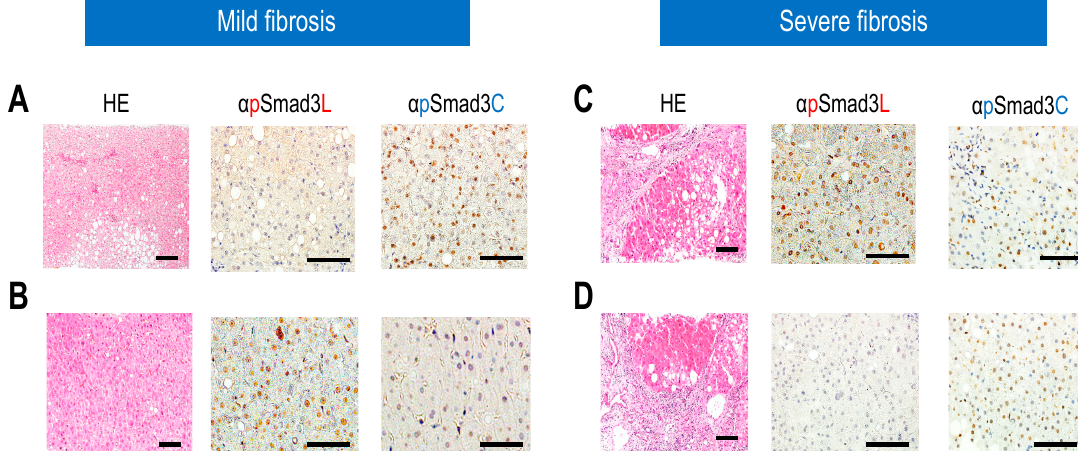
Figure 2. Two distinct hepatocytic Smad phospho ‐ isoform signaling pathways in livers with nonalcoholic steatohepatitis (NASH): pSmad3L ‐ dominant and pSmad3C ‐ dominant. ( A ) This liver specimen showing mild fibrosis (hematoxylin ‐ eosin on HE column) was obtained from patient 5 in Table 1, who had not developed hepatocellular carcinoma (HCC) for 15 years following histopathologic diagnosis of NASH. Hepatocytes retained phosphorylation at Smad3C ( α pSmad3C column) but showed little phosphorylation at Smad3L ( α pSmad3L column). ( B ) This liver specimen was obtained from patient 18 in Table 1, who developed HCC within 8 years after liver biopsy. The specimen showed degrees of fibrosis and necroinflammatory activity similar to those in ( A ). Smad3 in hepatocytic nuclei was phosphorylated sparsely in the C ‐ terminal region ( α pSmad3C column) but intensely in the linker region ( α pSmad3L column). ( C ) In the cirrhotic liver specimen obtained from patient 26 in Table 1 who was diagnosed with HCC at the time of liver biopsy, phosphorylation of Smad3L in hepatocytic nuclei was high, while C ‐ terminal phosphorylation of Smad3 was suppressed. ( D ) In another cirrhotic liver specimen, obtained from patient 17 in Table 1, HCC had not developed during 13 years following liver biopsy. Hepatocytic nuclei showed high phosphorylation at Smad3C but low phosphorylation at Smad3L. The specimen showed degrees of fibrosis and necroinflammatory activity similar to those in ( C ). Formalin ‐ fixed, paraffin ‐ embedded liver sections were stained with anti ‐ pSmad3L Ab ( α pSmad3L column) and anti ‐ pSmad3C Ab ( α pSmad3C column). Abs then were bound by goat anti ‐ rabbit IgG conjugated with peroxidase ‐ labeled polymer. Peroxidase activity was detected using 3,3 ′‐ diaminobenzidine tetrahydrochloride. Antibody ‐ treated sections were counterstained with hematoxylin (blue). Brown color indicates specific Ab reactivity. Table 1. Clinicopathologic features and Smad2/3/L/C phosphorylation in liver specimens from patients with NASH.